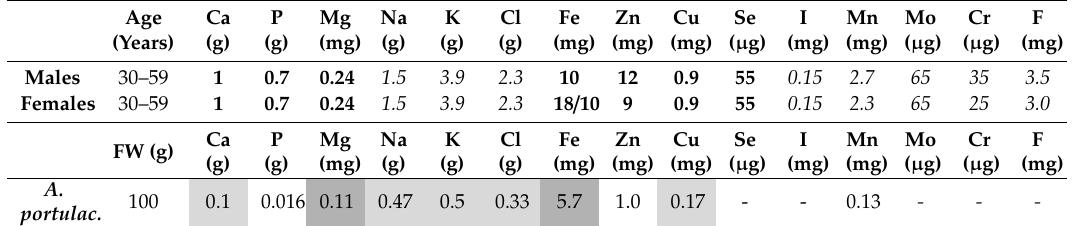
Table 5. Recommended Dietary Allowance (RDA in bold) and Adequate Intake (AI in italics) of minerals for the Italian adult population, and the mineral intake provided by 100 g FW of A. portulacoides